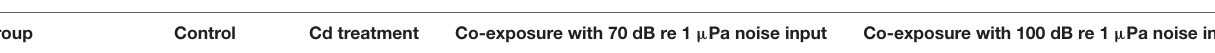
Concentration ( µ g/L) Significant differences are indicated by different